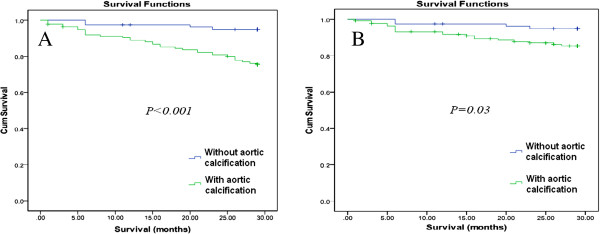
Kaplan-Meier curves for patients with and without abdominal aortic calcification. A) All-cause mortality; B) cardiovascular mortality.